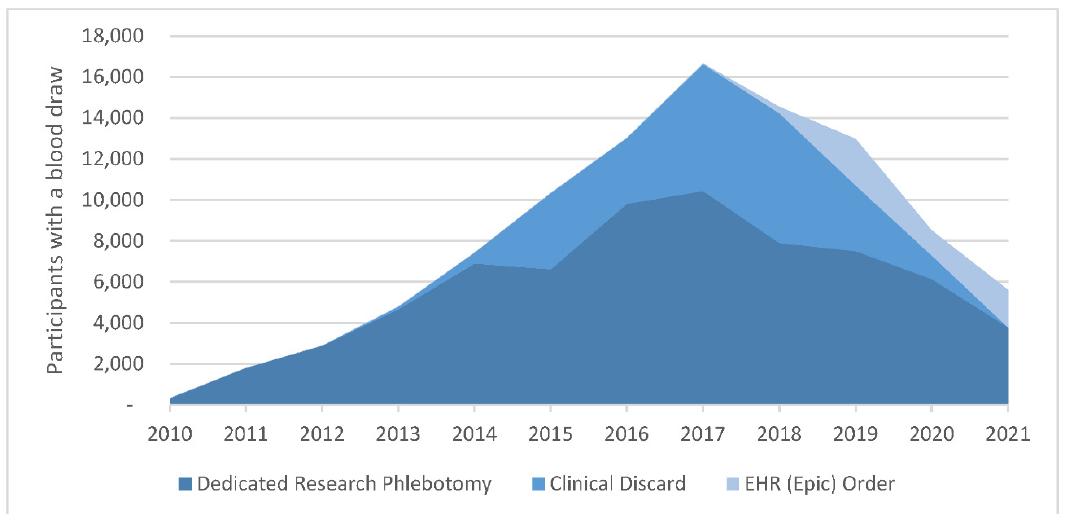
Figure 2. Biospecimen Collection by Method.